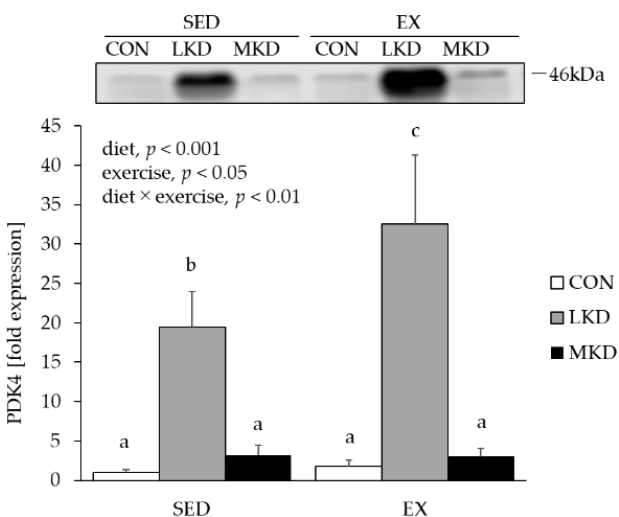
Figure 5. Protein expression of PDK4 in epitrochlearis muscle tissue. Two-way ANOVA was performed, followed by a Tukey–Kramer multiple-comparison test. Means of treatments labeled with the same letter are not significantly different from each other. Values are means ± SEM, n = 7. A representative western immunoblot image is shown.